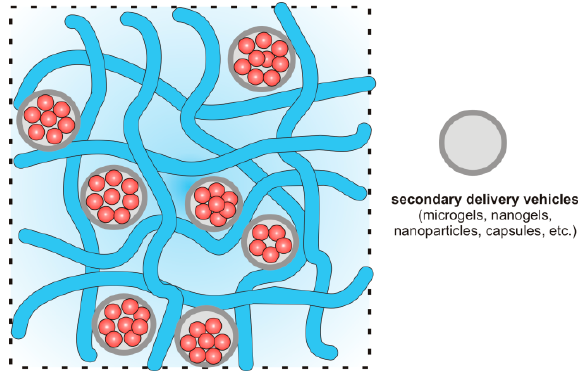
Figure 7. Structure of “plum pudding gels” (PP gels). Composite HG containing a drug embedded in a secondary controlled delivery vehicle (microgels, nanogels, nanoparticles, capsules,